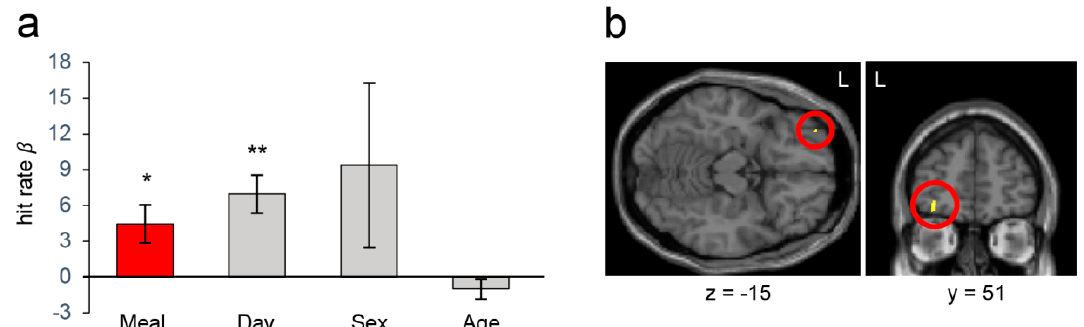
Figure 3. Behavioural and VBM results of analyses that included data from all participants. ( a ) The effects ( β weights) on the hit rate in the 2-back condition in the N-back task based on meal (MCT/placebo), day (1st/2nd visit), sex, and age. Consuming the MCT meal significantly improved the hit rate. Error bars depict SEM; * p < 0.05, ** p < 0.01. ( b ) A region in the left DLPFC whose grey matter volume showed a significantly negative correlation with the degree of hit rate improvement by the MCT meal (red circle). L: left.